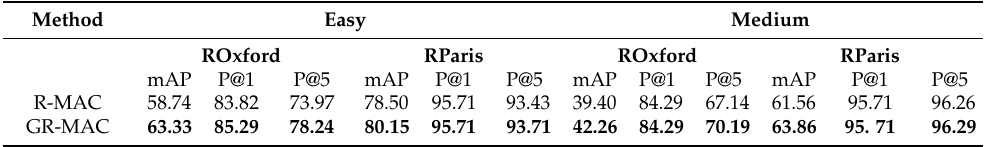
Table 2. Performance (mAP) comparison between regional maximum activation of convolutions (R-MAC) [25] and generalized R-MAC (GR-MAC) on ROxford and RParis data sets. The best result is highlighted in